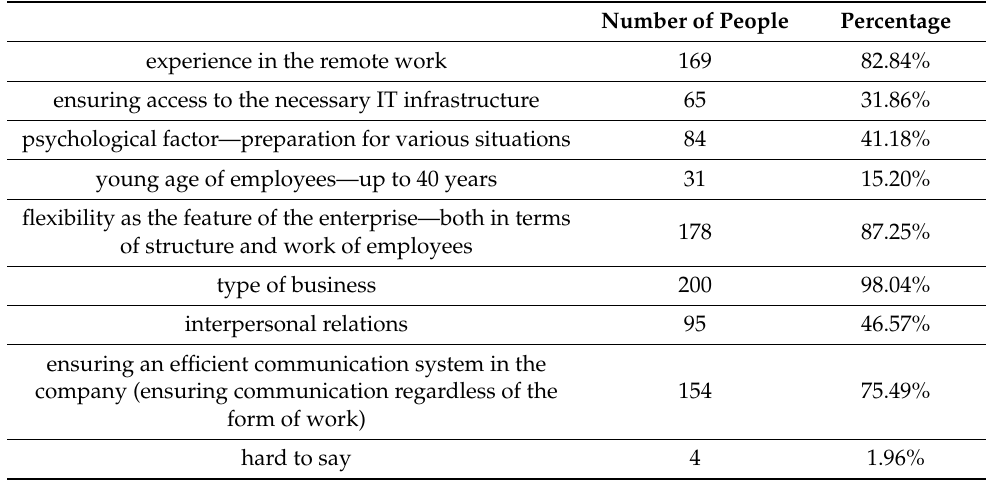
Table 1. Main problems and development challenges of cities.